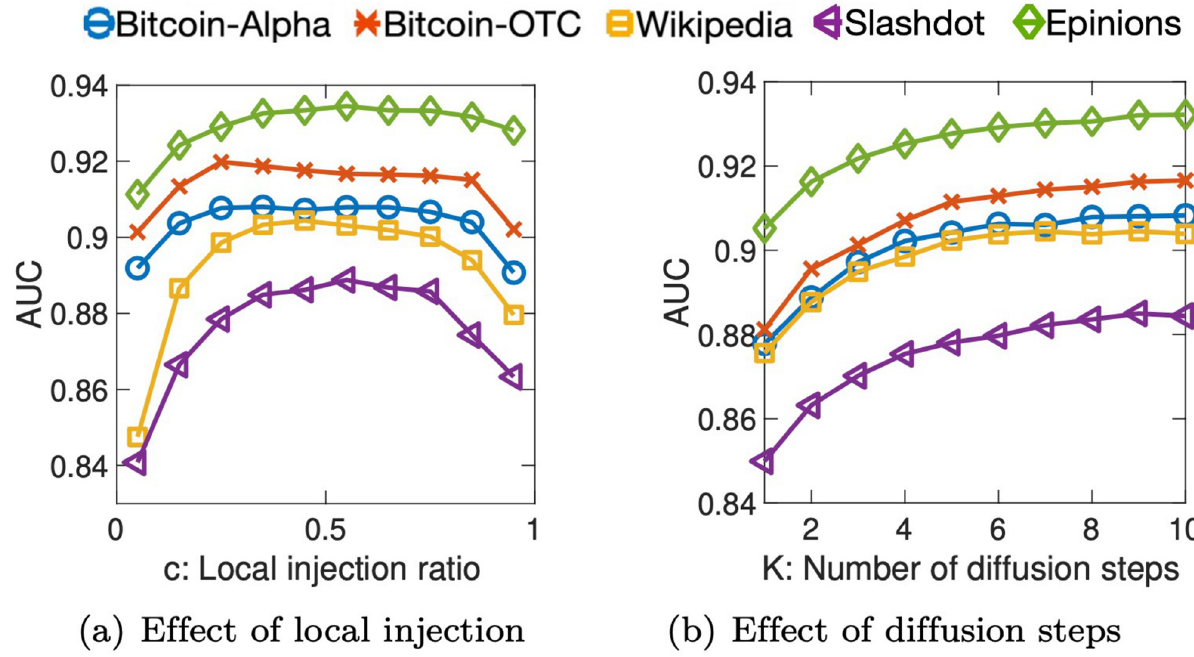
Fig 3. Effects of the local injection ratio c and the number K of diffusion steps of S ID N ET . (a) A relatively small value (0.15 * 0.35) of c is the best for Bitcoin-Alpha and Bitcoin-OTC while c around 0.5 shows the best accuracy for the others. (b) The performance of S ID N ET improves and converges as K increases (Theorem